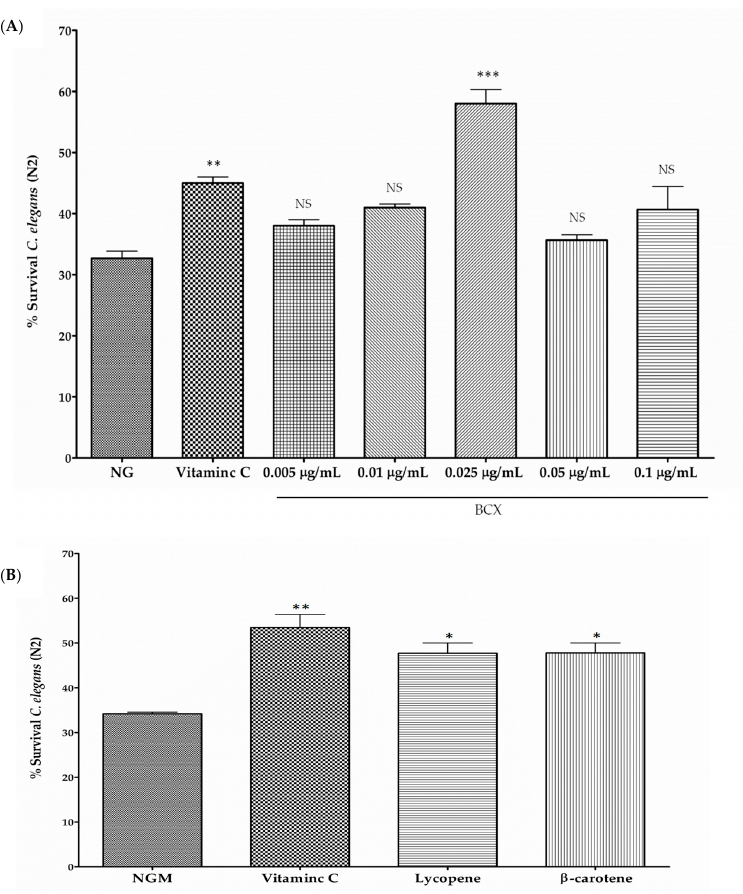
Figure 5. Percentage of C. elegans worm’s survival after an acute oxidative stress with 2 mM of H 2 O 2 . Vitamin C (0.1 μ g/mL) was used as positive control. ( A ) Worms were fed at different concentrations of commercial β‐ Cryptoxanthin (BCX). Survival values correspond with the mean of three independent experiments; ( B ) Antioxidant activity of C. elegans fed with carotenoids lycopene and β‐ carotene at the dose of 0.025 μ g/mL. In both experiments, Vitamin C (0.1 μ g/mL) was used as antioxidant positive control. Survival values correspond with the mean of at least two independent experiments. *** p ‐ value ≤ 0.001, ** p ‐ value ≤ 0.01, * p ‐ value ≤ 0.05, NS: not significant. NGM: nematode growth medium.